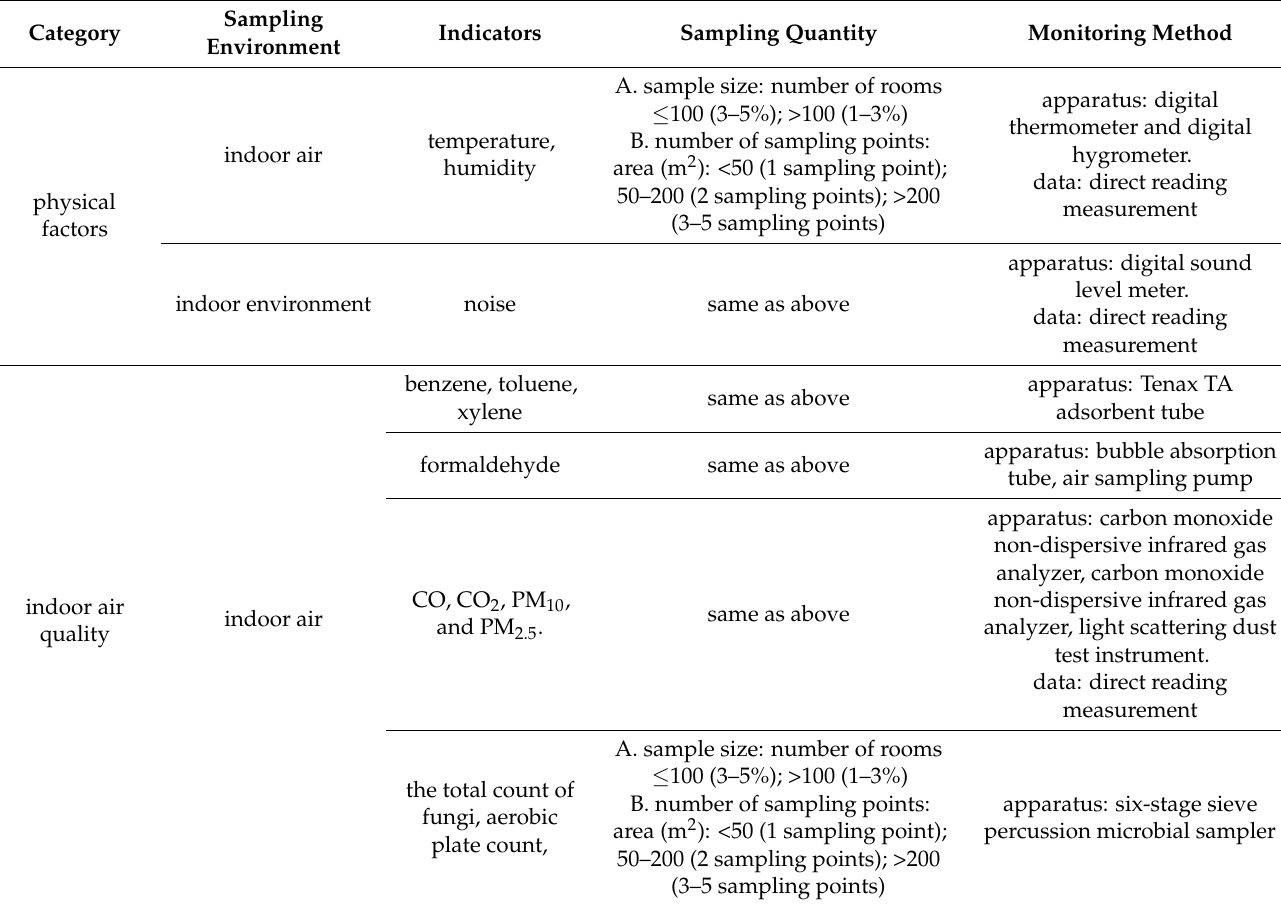
Table 1. List of environmental monitoring indicators for